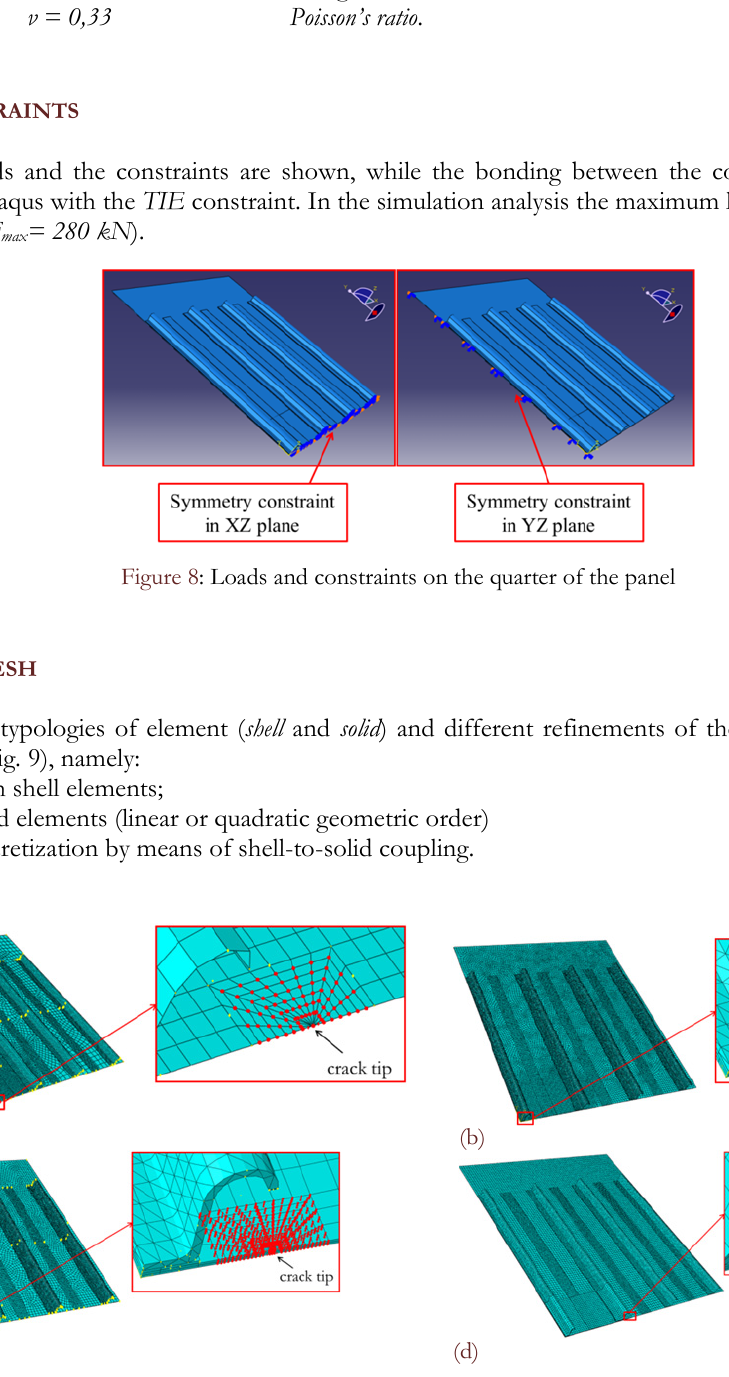
Figure 9: Different modeling typologies: second-order shell elements with collapsed Quarter-Point Node elements at the crack tip (a), first-order solid elements collapsed at the crack tip (b), second-order solid elements with collapsed Quarter-Point Node elements at the crack tip (c), same as (a) - (c) with shell-to solid coupling between solid and shell parts